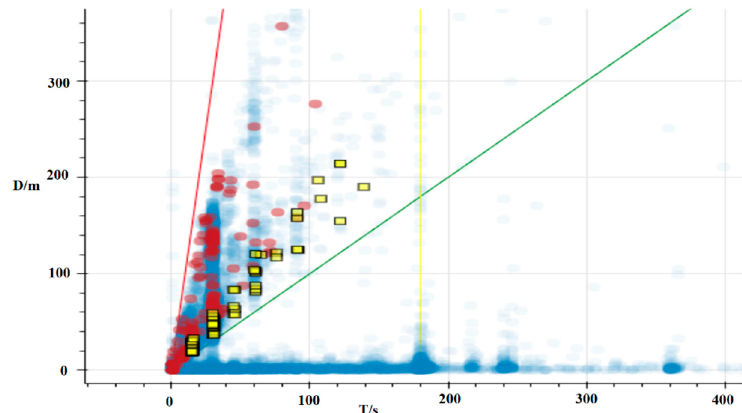
Figure 4. Scatter plot of the differential distance in the spatiotemporal space.